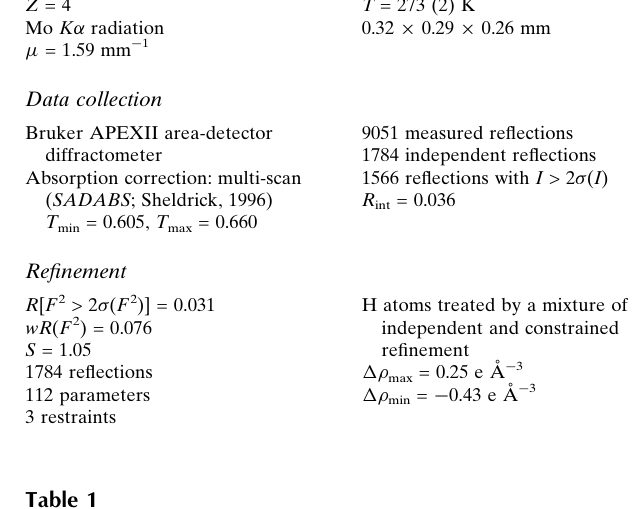
Hydrogen-bond geometry (A˚ , (cid:2)